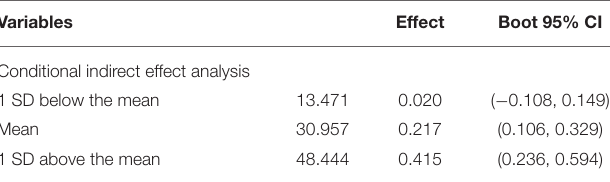
TABLE 5 | The moderating effect of compassion fatigue.